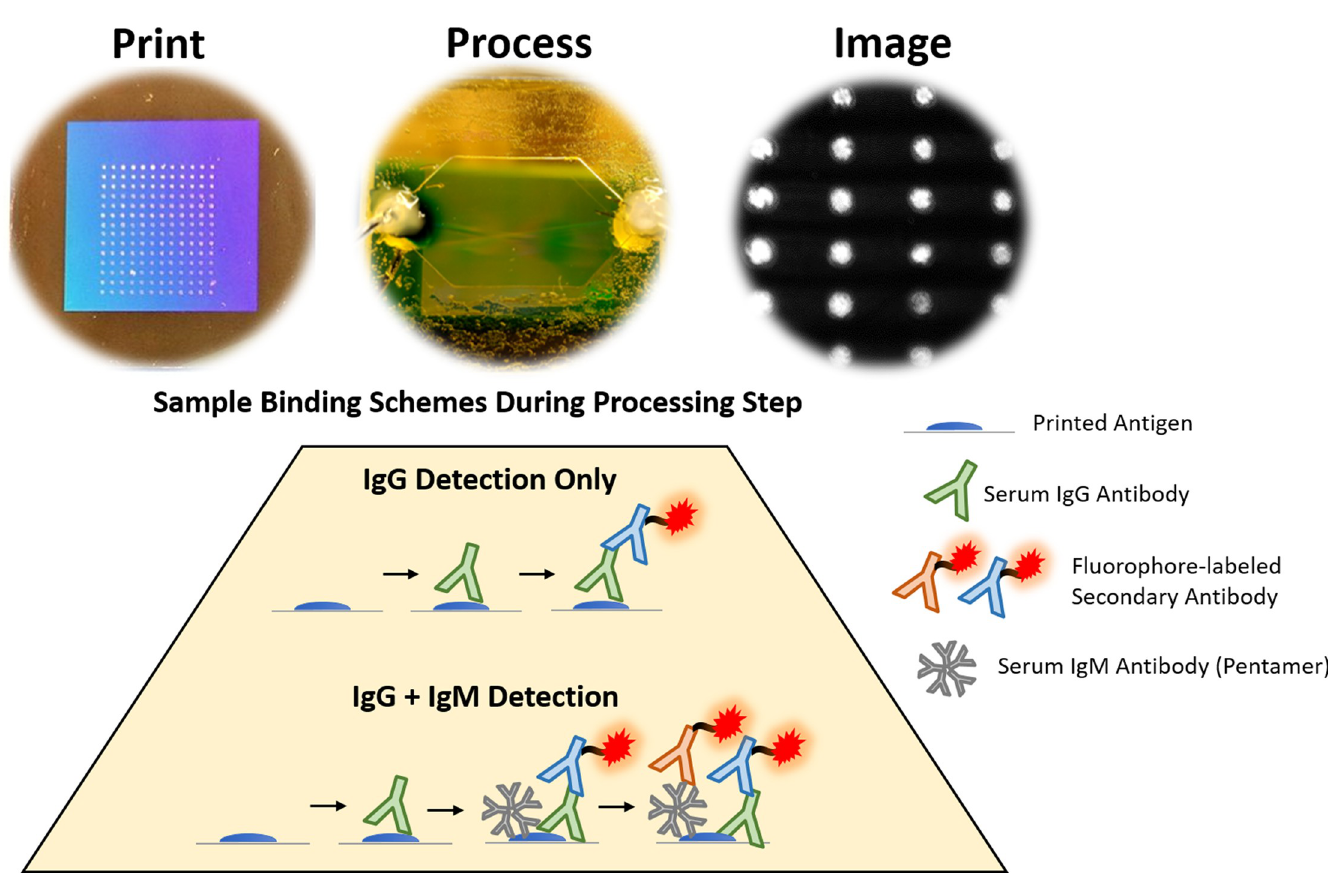
Fig 2. Summary of the experimental workflow for detecting LD-relevant serum antibodies. After printing a biochip with antigen spots in the grating area, the biochip is assembled to form a microfluidic chamber. Various reagents are flowed through the biochip during the microfluidic step, in which serum samples are flowed through the biochip. For detection of serum IgG only, a fluorophore-labelled anti-IgG is applied to the chip after the serum sample. For detection of the combined signal of IgG and IgM (secreted in the serum as a pentamer) against each target, fluorophore-labelled anti-IgM is added after the anti-IgG.